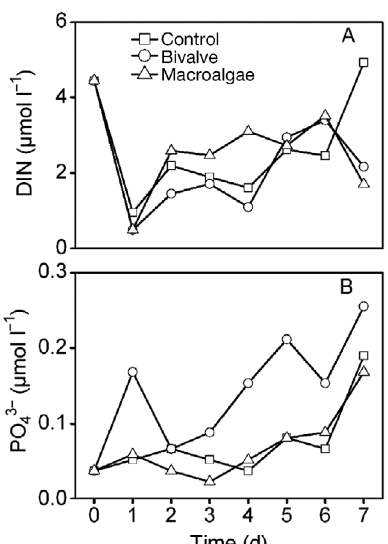
Fig. 6. Variations in concentrations of (A) dissolved inor- ganic nitrogen (DIN) and (B) PO 43− in the enclosure experi- ments over time